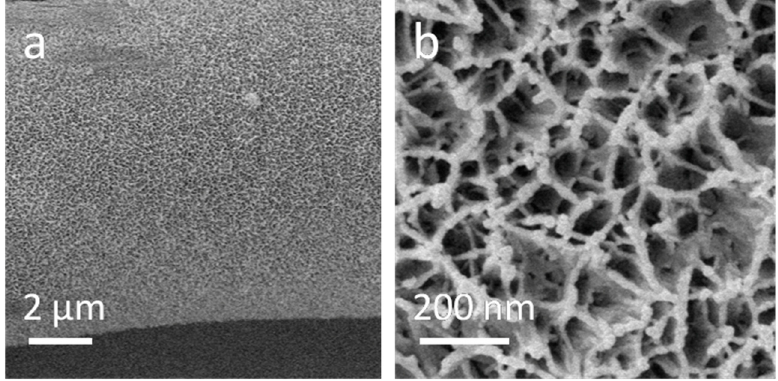
Figure 2. Low-resolution SEM image ( a ) and high-resolution SEM image ( b ) of the Fe 2 O 3 @CC composite.